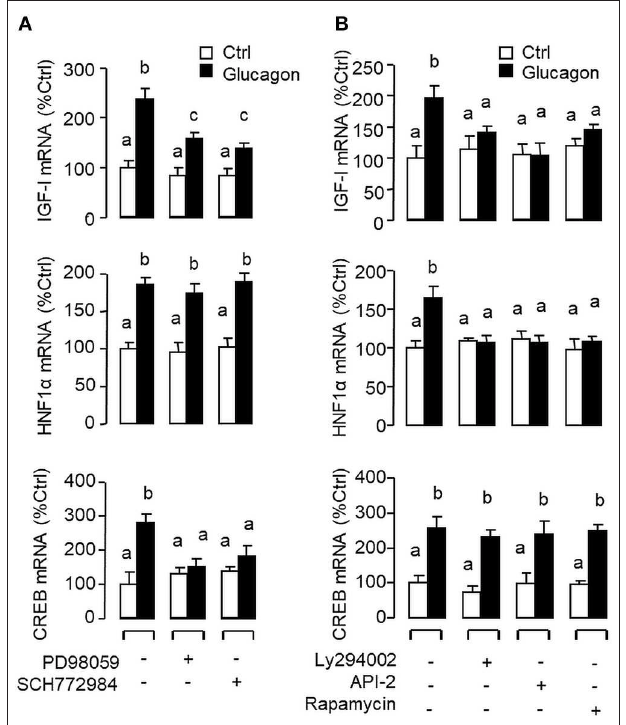
FIGURE 6 | Functional role of the MAPK and PI3K/Akt cascades in glucagon-induced IGF-I, HNF1 α , and CREB transcript expression at the hepatic level. Carp hepatocytes were treated with glucagon (10nM) for 12h in the presence of (A) the MEK 1 / 2 inhibitor PD98059 (10 µ M) or ERK 1 / 2 inhibitor SCH772984 (10nM) or (B) the PI3K inhibitor Ly294002 (10 µ M), Akt blocker API-2 (2 µ M), or mTOR inactivator Rapamycin (20nM). After drug